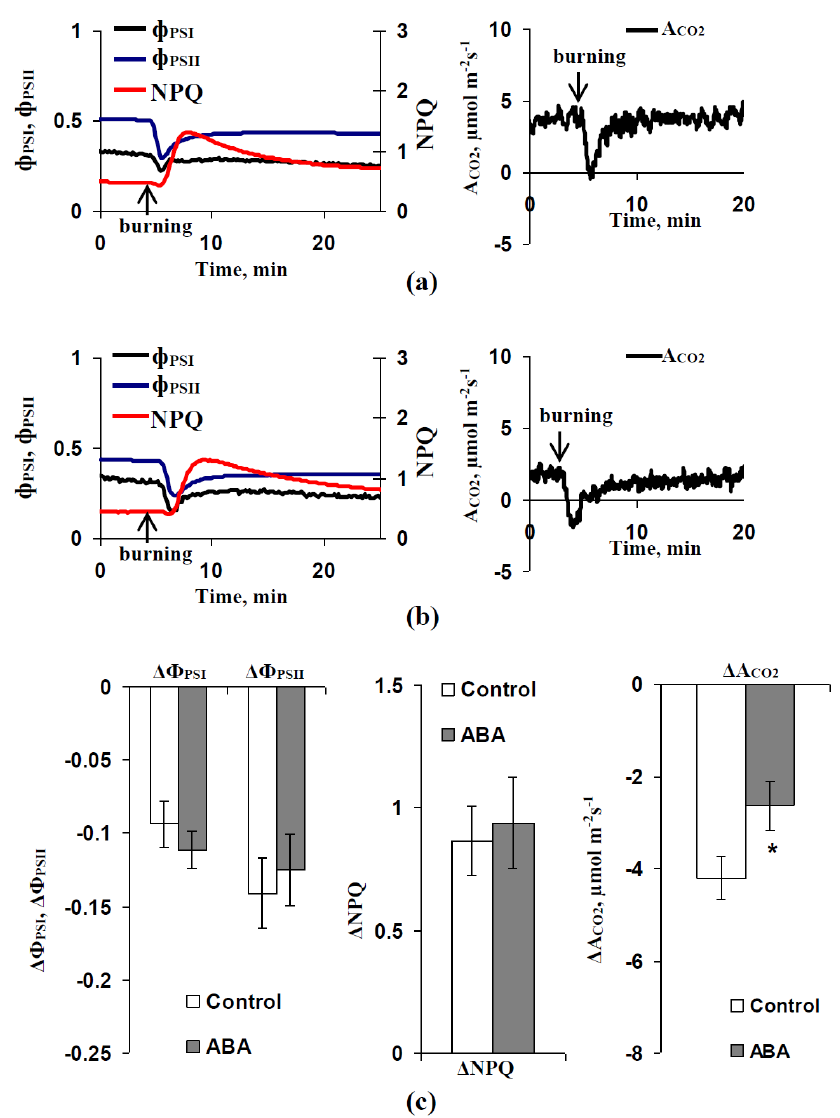
Figure 5. ( a ) Changes in quantum yields of photosystems I ( Φ PSI ) and II ( Φ PSII ), the non-photochemical quenching of chlorophyll florescence (NPQ), and the photosynthetic assimilation of CO 2 (A CO2 ) in the leaf of a control pea seedling after local burning. ( b ) Changes in quantum yields of photosystems I ( Φ PSI ) and II ( Φ PSII ), the non-photochemical quenching of chlorophyll florescence (NPQ), and the photosynthetic assimilation of CO 2 (A CO2 ) in the leaf of an ABA-treated pea seedling after local burning. (c) Average magnitudes of these changes in photosynthetic parameters in control seedlings and seedlings after the ABA treatment ( n = 5-7). The ABA treatment of seedlings was performed by spraying them with aqueous solutions (10 − 5 M) 1 day before photosynthetic measurements; control plants were treated with equal volumes of water. Photosynthetic measurements were performed in the second mature leaf; illumination by blue actinic light (239 µ mol m − 2 s − 1 ) was used. Local burning of the first mature leaf by a flame (3-4 s, about 1 cm 2 ) was performed 1.5 h after plant fixation for measurement. *, difference between experiment and control plants is significant ( p < 0.05).